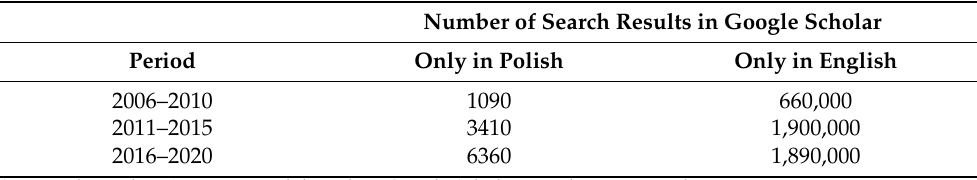
Table 1. Number of search results for academic publications containing the term “Twitter” from the year the service was created to the end of 2020 in the Google Scholar search engine. Number of Search Results in Google Scholar Period Only in Polish Only in